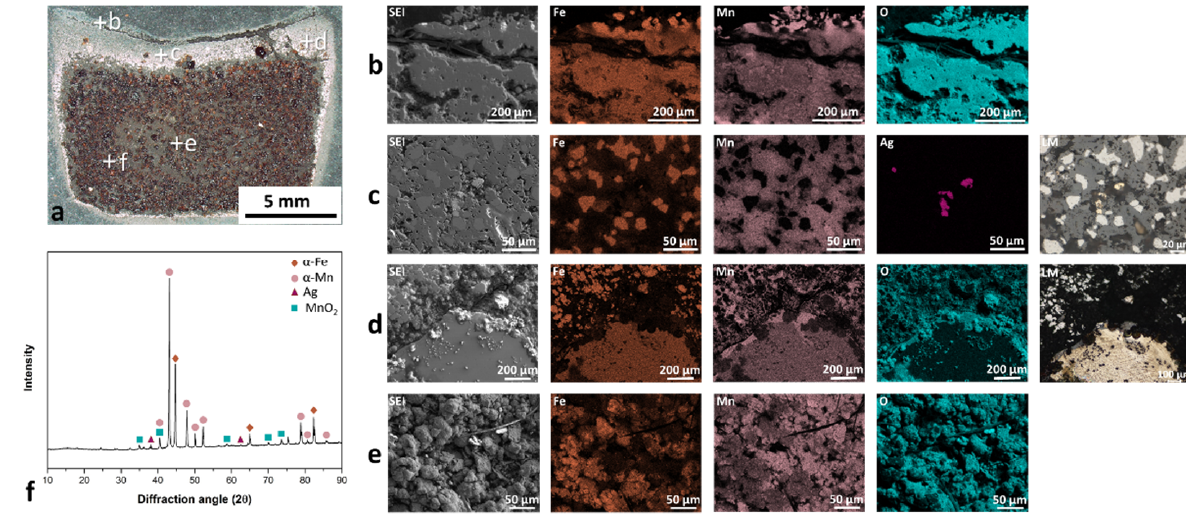
Figure 4. Sintering test for Fe-Mn-Ag powder mixture at 850 °C for 1 h: ( a ) macrograph of cross-section, ( b ) upper fully oxidized layer, which was partly resigned, ( c ) area with Mn oxide and completely pure Fe areas, ( d ) melted part as a result of the reused powder after the SLM process, surrounded with the sintered powder mixture, ( e ) in the mainly well-sintered area, ( f ) XRD spectra of sintered Fe-Mn-Ag material.